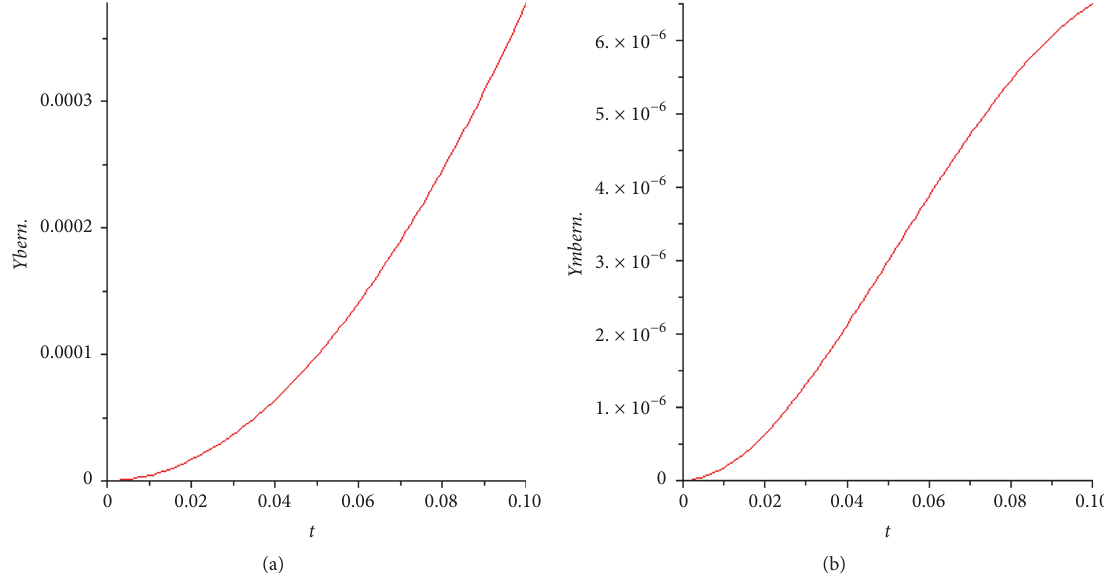
Figure 3: The absolute error between ADM with modified Bernstein polynomials and the exact solution when m=12, v=8, and k=3.